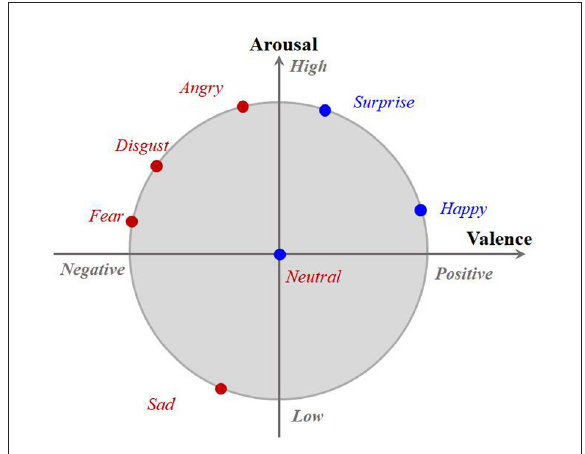
FIGURE2 The 2D arousal-valence emotion wheel proposed by Yang et al. (2022). It consists of two dimensions, where the horizontal axis denotes the degree of valence while the vertical axis corresponds to the arousal. Each typical discrete emotion can be mapped to one point in the emotion wheel according to its corresponding valence and arousal